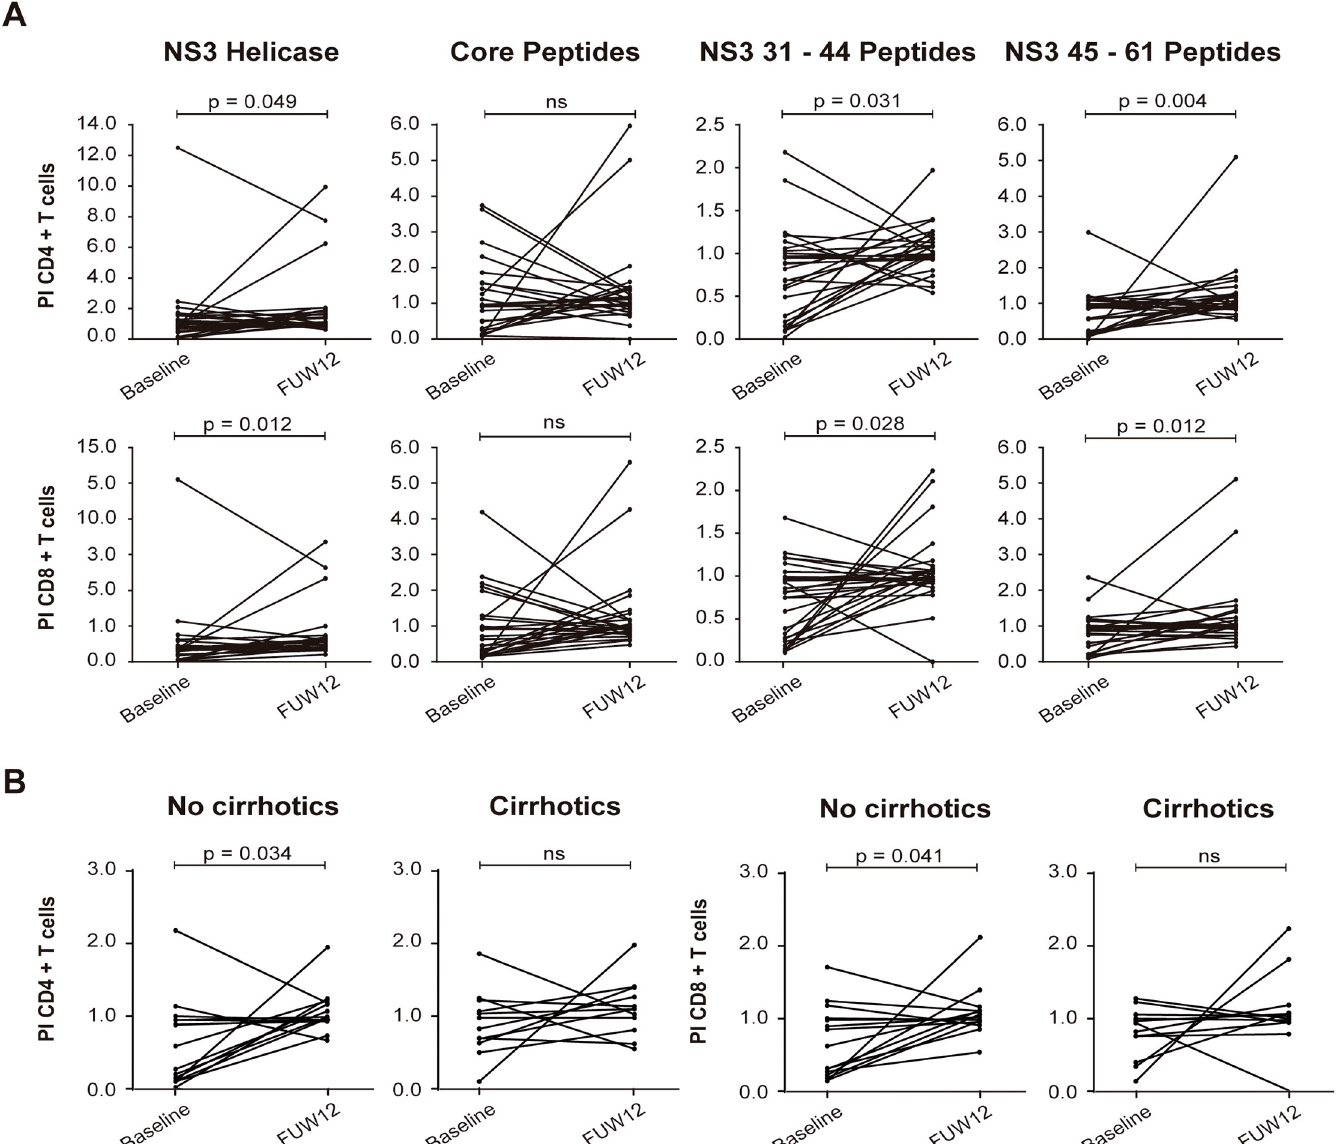
Fig 4. Proliferation responses of CD4+ and CD8+ HCV specific T-cells. In vitro expansion of PBMCs after 5 days of stimulation with HCV peptides (NS3 Helicase, Core Peptides, NS3 31–44 Peptides, NS3 45–61 Peptides). Proliferation capacity was calculated as the proliferation index, at baseline and FUW12, (A) Proliferation index of CD4+ and CD8+ T cells (N = 27). (B) T cells proliferation index according to score fibrosis when stimulated with NS3 31–44 Peptides. CD4+ and CD8+ T cells of non-cirrhotic patients (N = 15) and (N = 12) respectively, liver stiffness < 9.5 KPa; CD4+ and CD8+ T cells of cirrhotic patients (N = 12) and (N = 12) respectively, liver stiffness � 9.5 KPa. Statistical significance was determined by nonparametric Wilcoxon signed-rank test and represented by p-value. P < 0.05 was considered statistically significant.